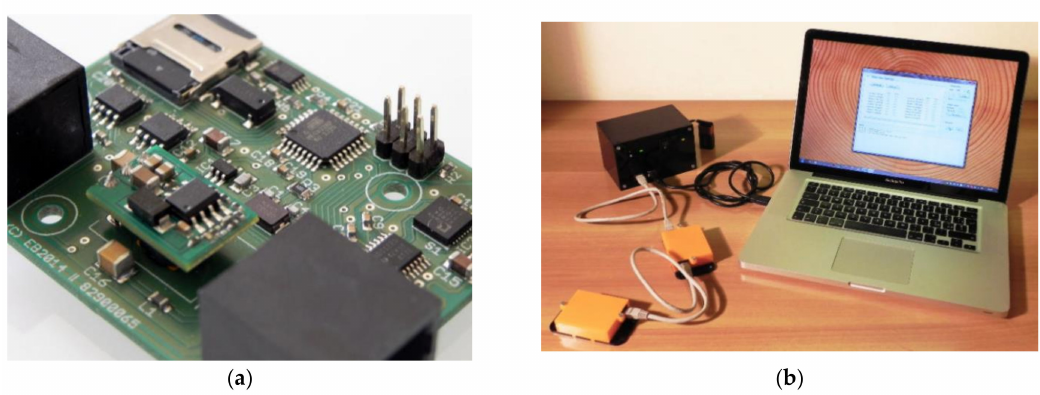
Figure 1. ( a ) PC board and ( b ) assembled